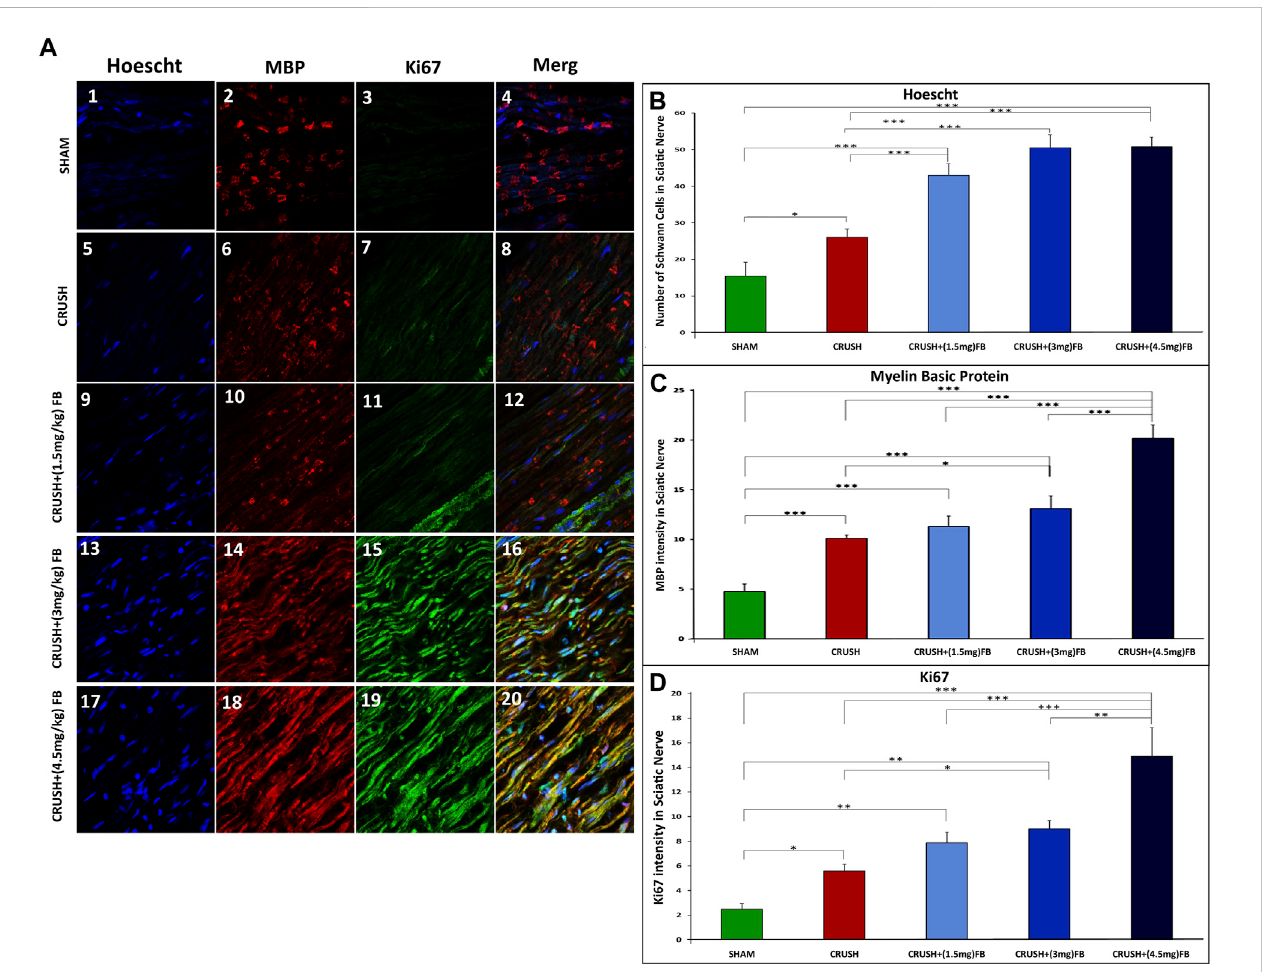
FIGURE 4 Whole-mount staining showing cell proliferation following sciatic nerve crush injury. Sciatic nerve was stained with myelin basic protein (MBP) in (A 2, 6, 10, 14 , and 18) and Ki67 antibodies in (A 3, 7, 11, 15 and, 19) to show the presence of myelinated SCs and cell proliferation (Ki67) at 4 weeks after nerve crush injury. Nuclei are counterstained with Hoechst dye (Ho) in (A 1, 5, 9, 13 and 17) . (B) Quanti fi cation of the number of individual SC nuclei among different experimental groups. The number of nuclei from 4 different sections was analyzed, and average data from fi ve independent experimental groups were compared. Data are expressed as mean ±SEM (n =8). * p < 0.05, ** p < 0.01, *** p < 0.001. (C) Quanti fi cation ofMBP fl uorescenceintensityindifferentgroups. MBP intensity was analyzed from 4 different sections, and average data from fi ve independent experimental groups were compared. Data are expressed as mean ± SEM (n = 8). * p < 0.05, ** p < 0.01, *** p < 0.001. (D) Quanti fi cation of Ki67 fl uorescence intensity in different groups. The intensity of Ki67-expressed cellswasanalyzedfrom4differentsections,andaveragedatafrom fi veindependentexperimentalgroupswerecompared.Dataareexpressedasmean±SEM (n = 8). * p < 0.05, ** p < 0.01, *** p <